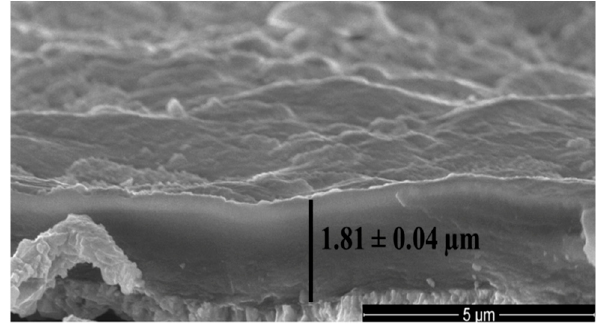
Figure 6. Scanning Electron Microscope (SEM) images for graphene coatings: ( a ) before corrosion test; ( b ) after corrosion test.